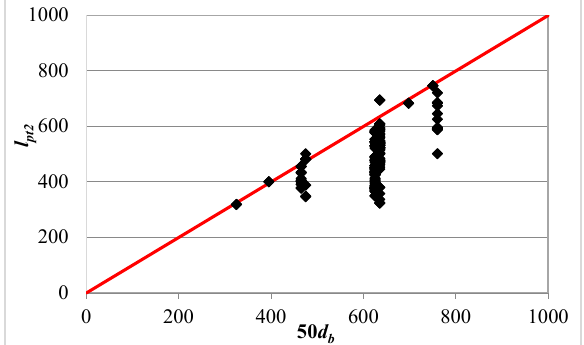
Figure 16. Calculated transfer length l pt2 versus 50 d b .